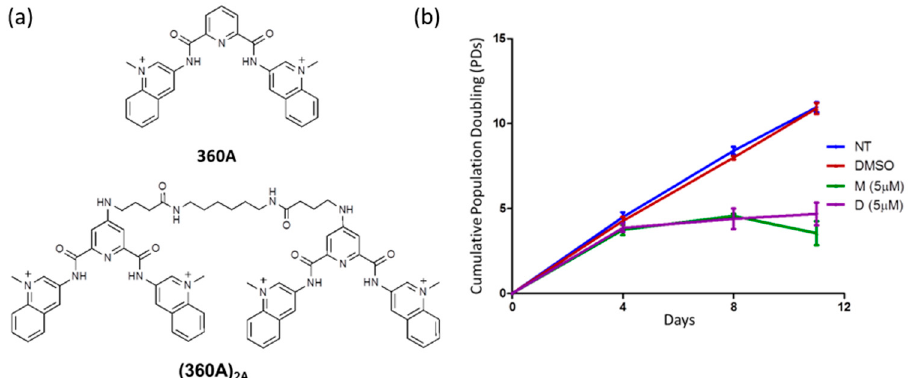
Figure 1. Chemical structure of 360A and (360A) 2A and the effect of these ligands on the proliferation of A549 cells: ( a ) Chemical structure of G4 ligands 360A and (360A) 2A ; ( b ) Cell growth curves plotting mean PDs and days in culture of non-treated A549 (NT), A549 treated with 0.1% DMSO (DMSO), with 5 µ M of 360A (M), or with 5 µ M of (360A) 2A (D) (n = 3 independent experiments; error bars, SD).